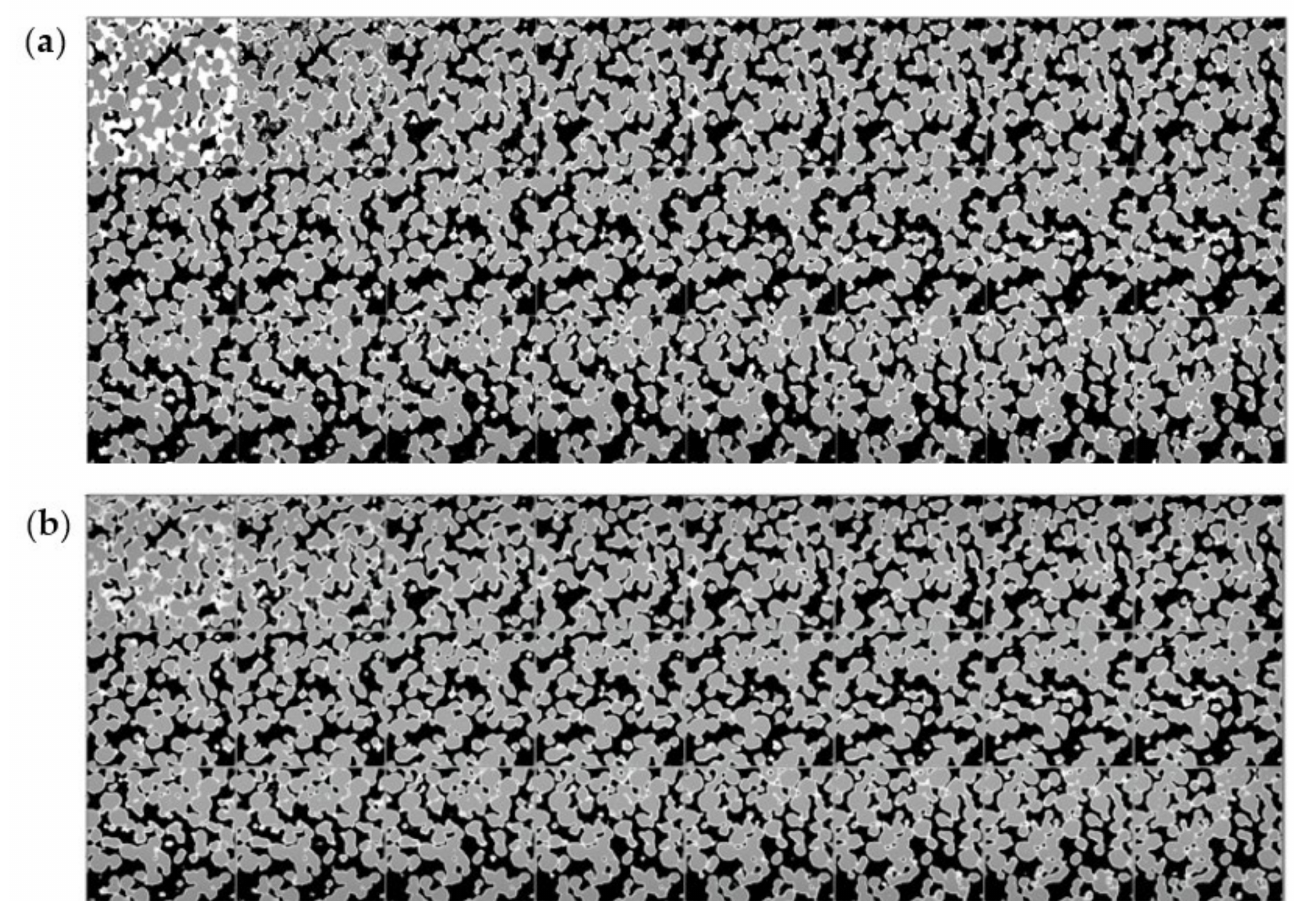
Figure 10. ( a ) A sample 3D calendered mini microstructure with size 24 × 224 × 224 ( b ) Reconstructed 3D microstructure from the 3-layer 3D CAE trained on the calendered + uncalendered dataset with a sliding window length of 24 and stride of